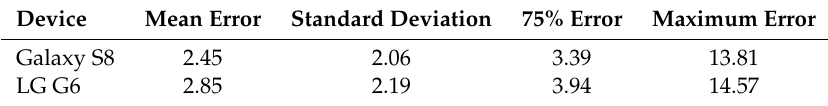
Table 3. Results statistics when training data are collected with a continuous